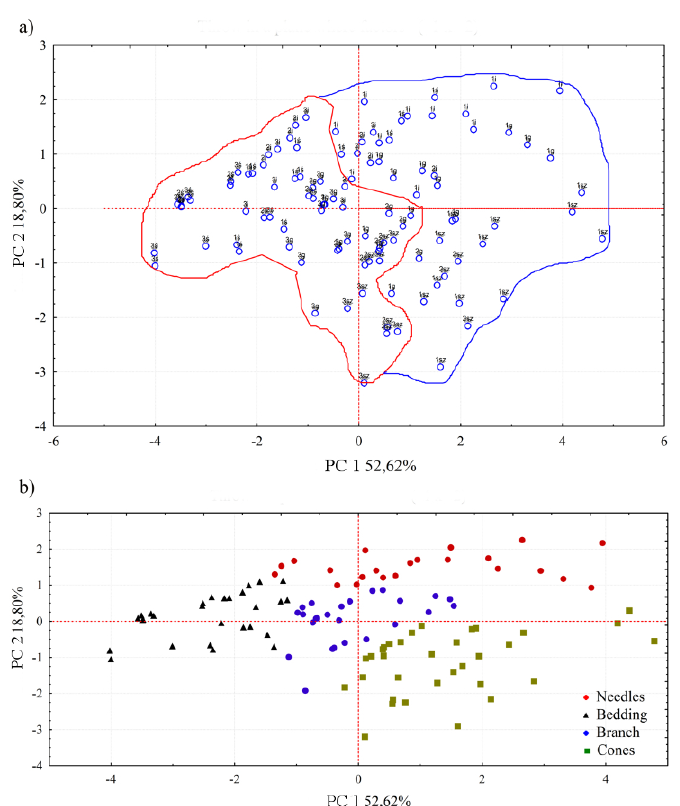
Figure 5. a) The projection of samples on the space defined by the first two principal components, b) the projection of samples on the space defined by the first two principal components and selected groups. Table 2. Summary of the best methods for preparing plant samples for analysis and the recovery procedures for the preparation of samples for analysis.